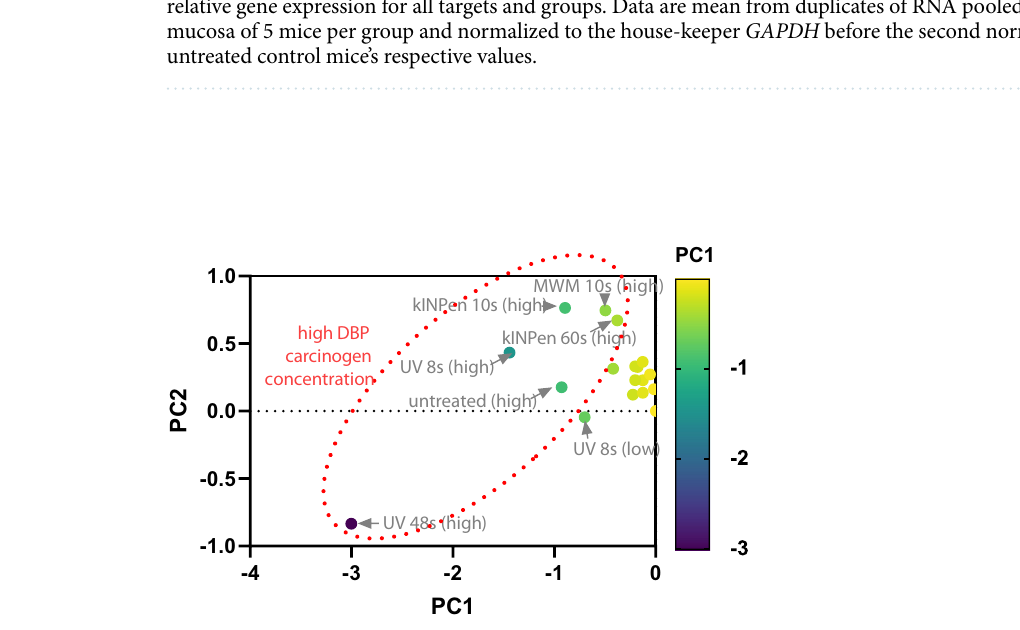
Figure 7. Principal component analysis of gene expression. Only genes consistently expressed across all groups were included for each treatment group and regimen in the principal component analysis (PCA), indicating the dibenzo(a)pyrene (DBP) high regimen (arrowheads) to differ in general much greater from the DBP low and the DBP none groups, in which the plasma or ultraviolet treatment only gave a minor effect (bubble cluster of all samples at the right